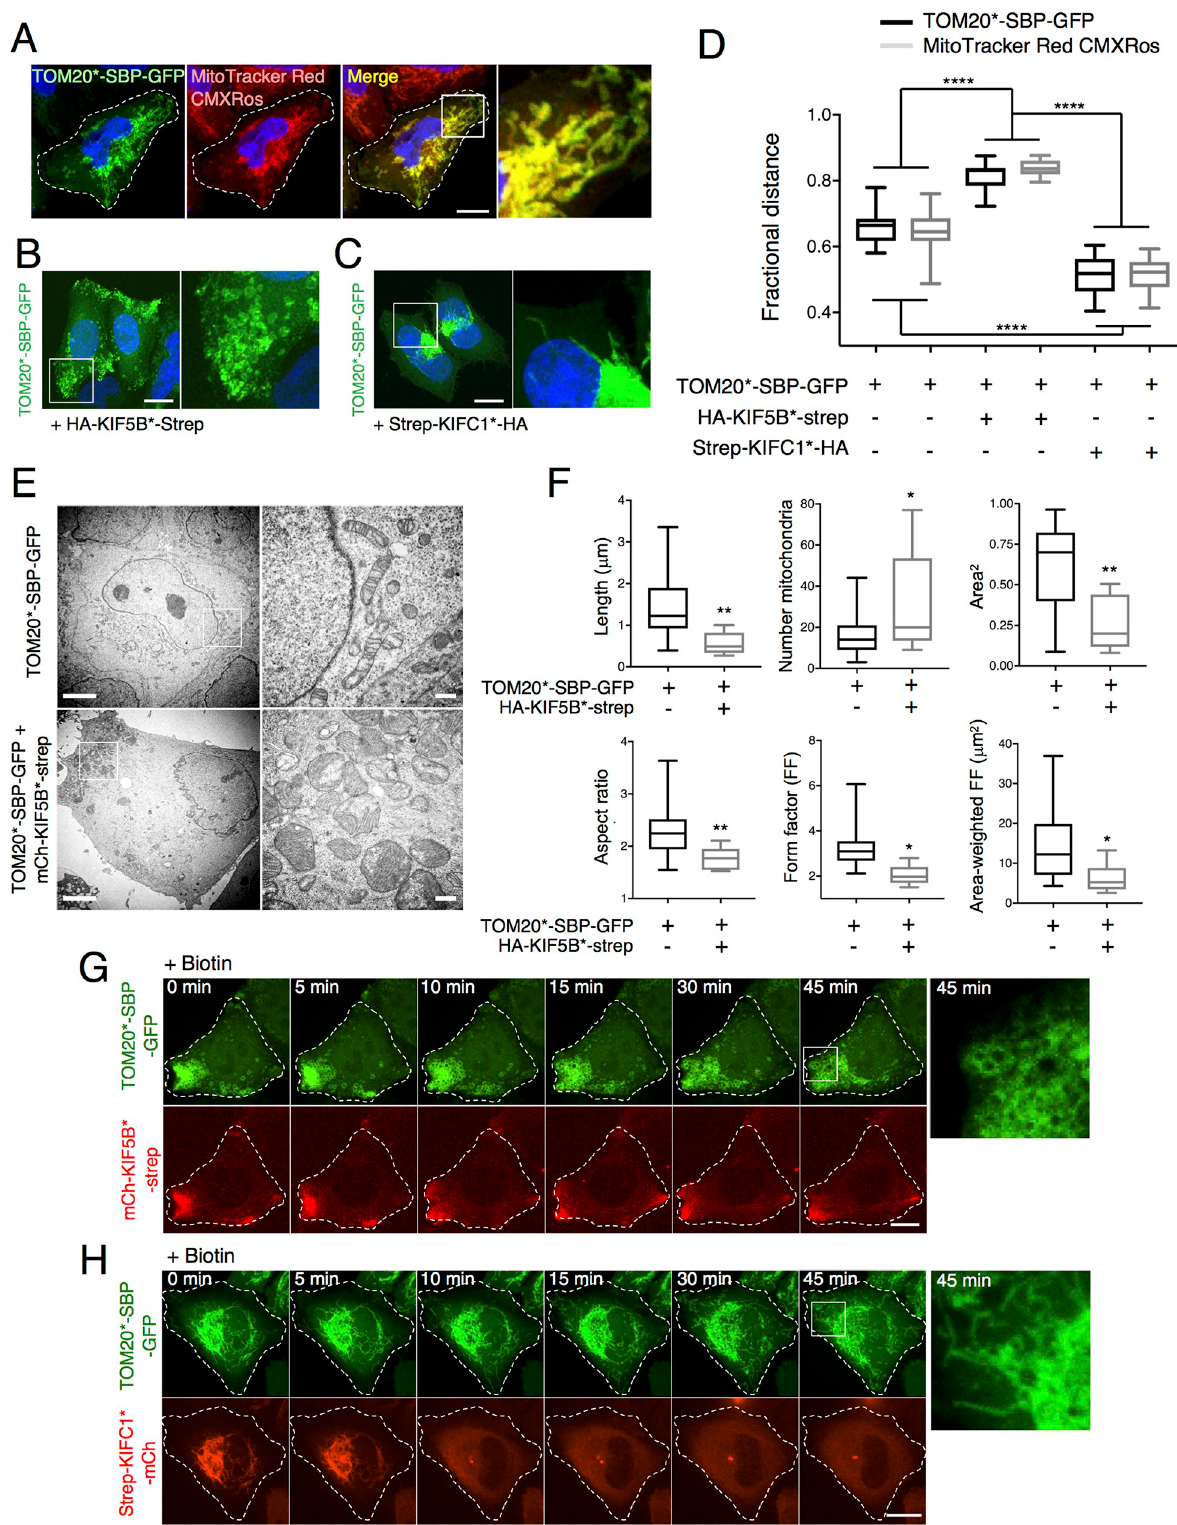
Fig 5. Redistribution of mitochondria to the cell periphery alters their shape. (A) Colocalization of TOM20 � -SBP-GFP with 25 nM MitoTracker Red CMXRos in HeLa cells incubated for 30 minutes at 37˚C, 5% CO 2 . (B) Coexpression of TOM20 � -SBP-GFP with HA-KIF5B � -strep causes